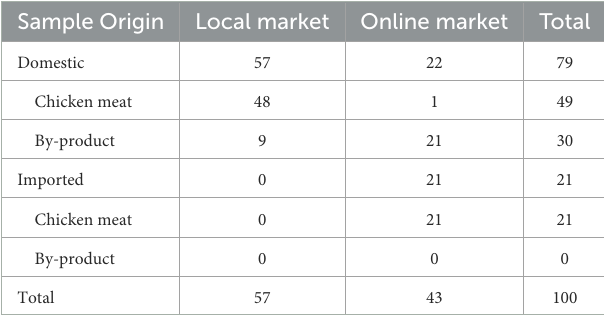
TABLE 1 The type and number of samples collected from the